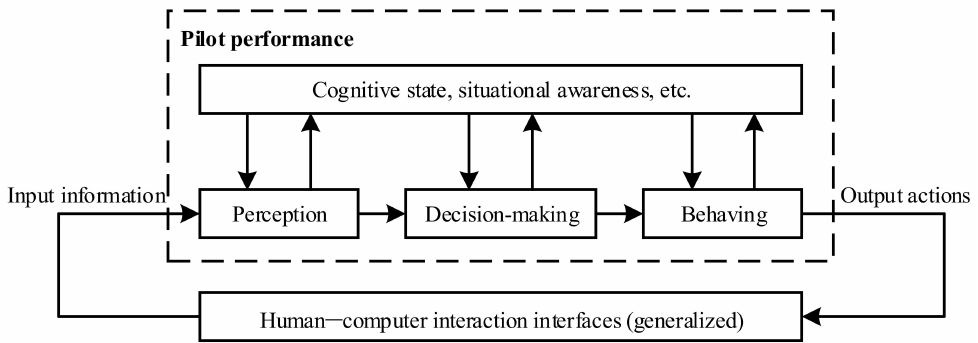
Figure 4. Human–machine–environment closed-loop circuit in the